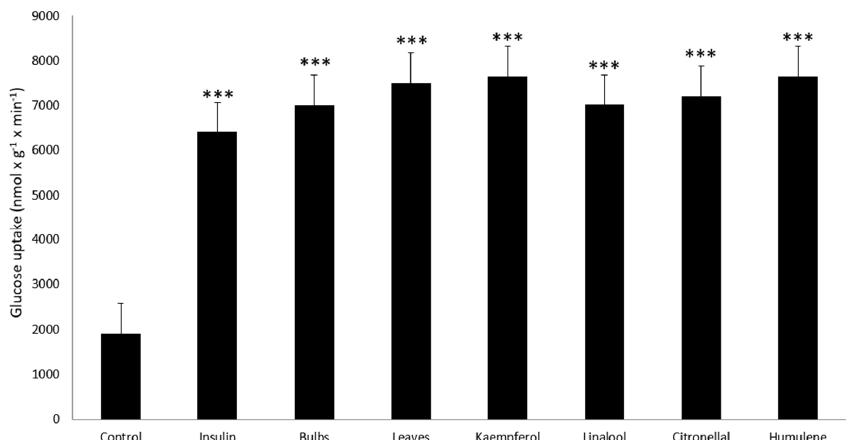
Figure 3. Anti-diabetic activity of L. candidum extracts and compounds. The glucose uptake of the 3T3 adipocytes was determined. Adipocytes were treated with ethanol extracts of L. candidum and with the compounds detected in those extracts. Negative control consisted of untreated adipocytes; insulin was used as a positive control. Data from three independent experiments are shown (mean ± SD). *** p < 0.001.